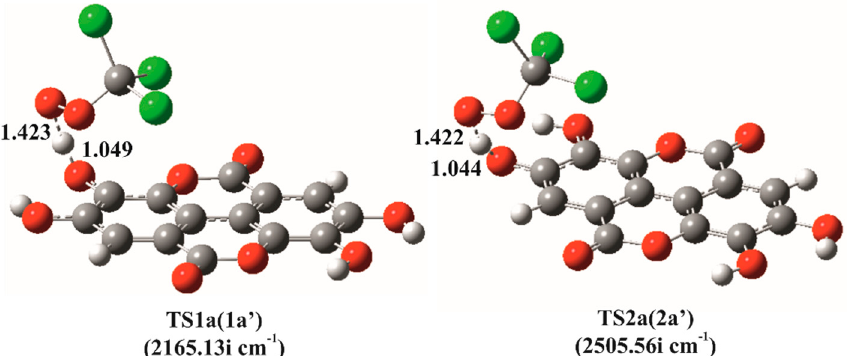
Figure 4. Optimized geometries of transition states for the hydrogen atom transfer (HAT) reaction